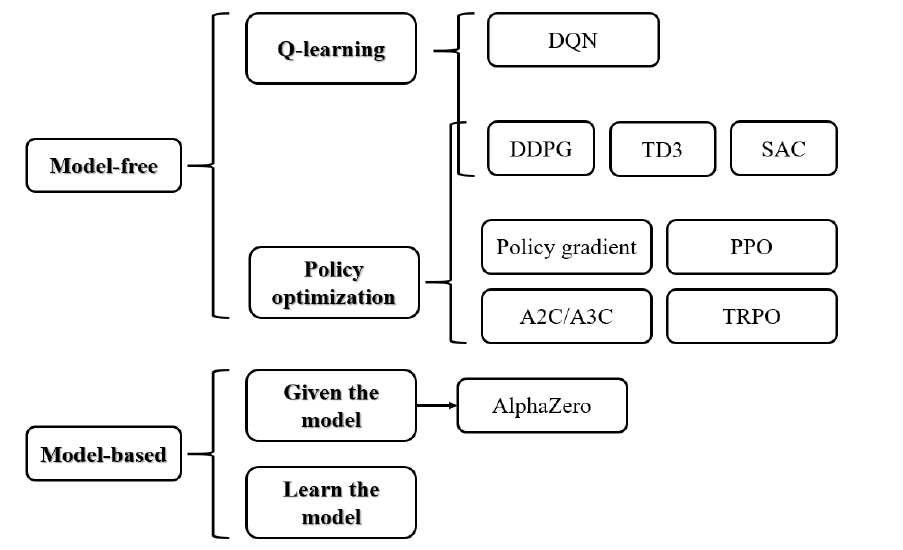
Figure 3. The taxonomy of representative RL Algorithms (For more information, see